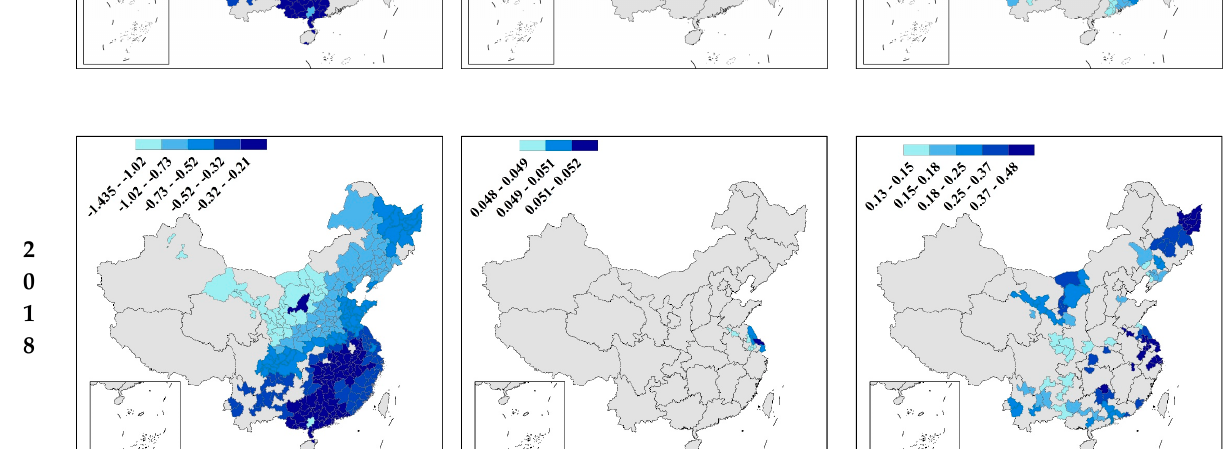
Figure 5. Spatial distributions of the coefficients of ∆ NDVI, ∆ Precipitation, and Intercept for the daytime MGWR model in 2005, 2010, 2015, and 2018.